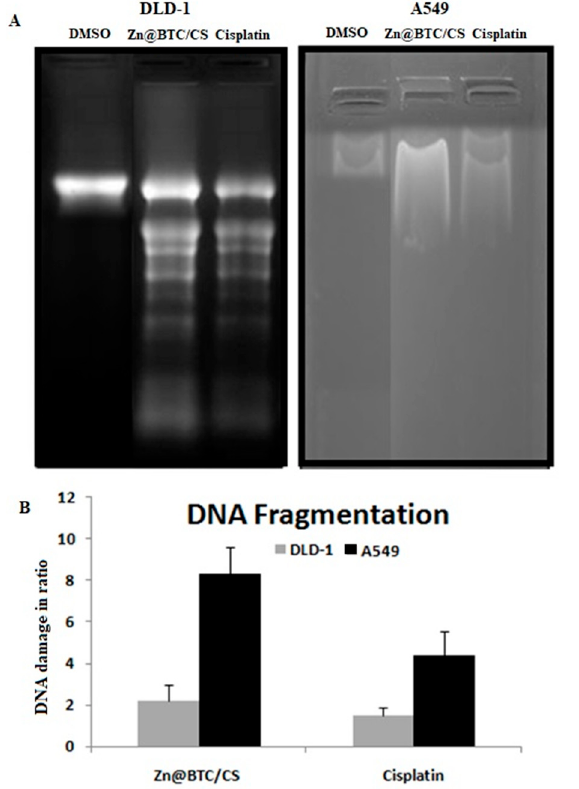
Figure 6. The DNA fragmentation effect of Zn-BTC@CS on lung and colon cancer cell lines showing ( A ) DNA gel electrophoresis and ( B ) DNA damage plot. Values are expressed as the mean ± S.D. of 3 independent experiments.